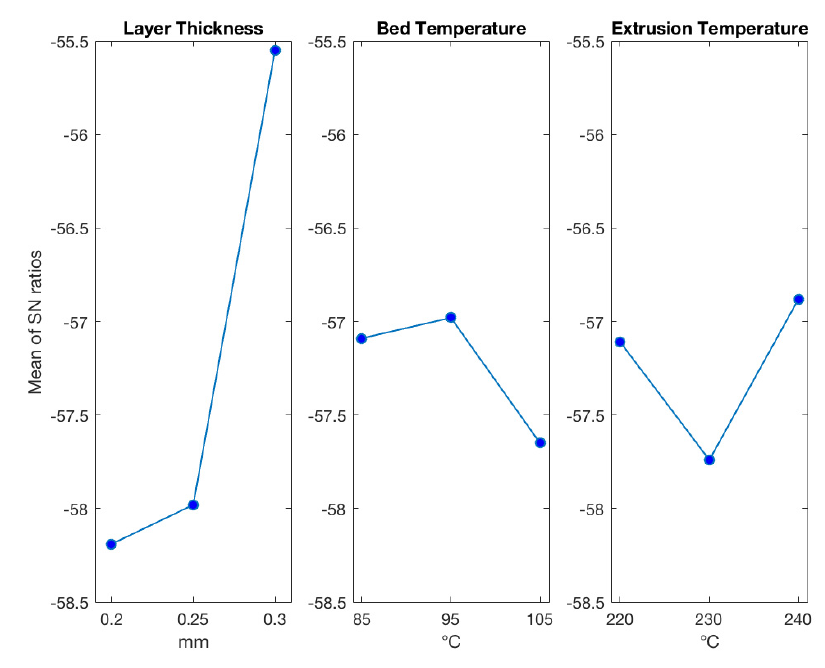
Figure 11. Experimentally derived results for warpage.